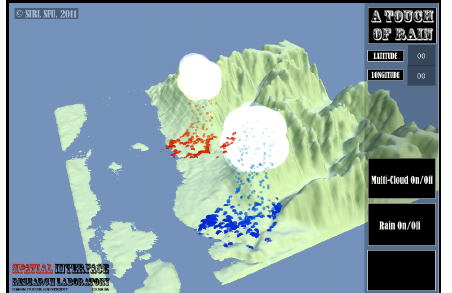
Figure 2. An early A Multi Touch of Rain prototype in two- user mode with a DEM of Vancouver’s North Shore mountains.